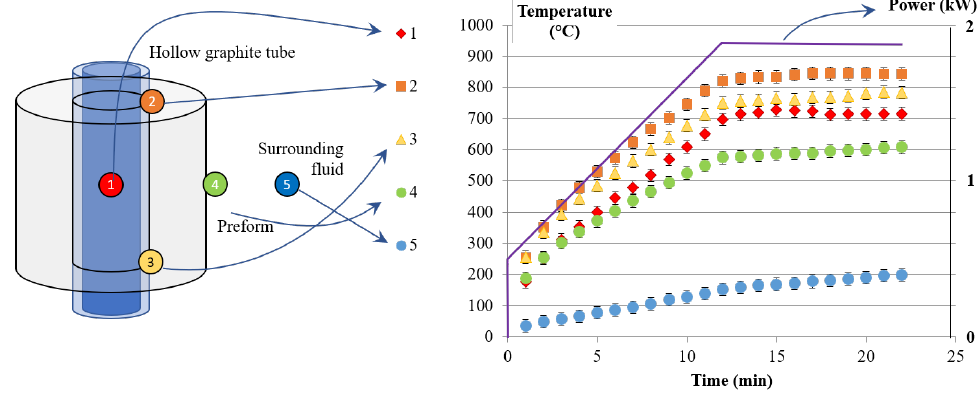
Figure 7. Thermal study: ( left ) position of the thermocouples; ( right ) thermal history. It can be seen that the thermocouples inserted between the preform and the heating tubes were those that recorded the highest temperatures, even more so for the thermo-